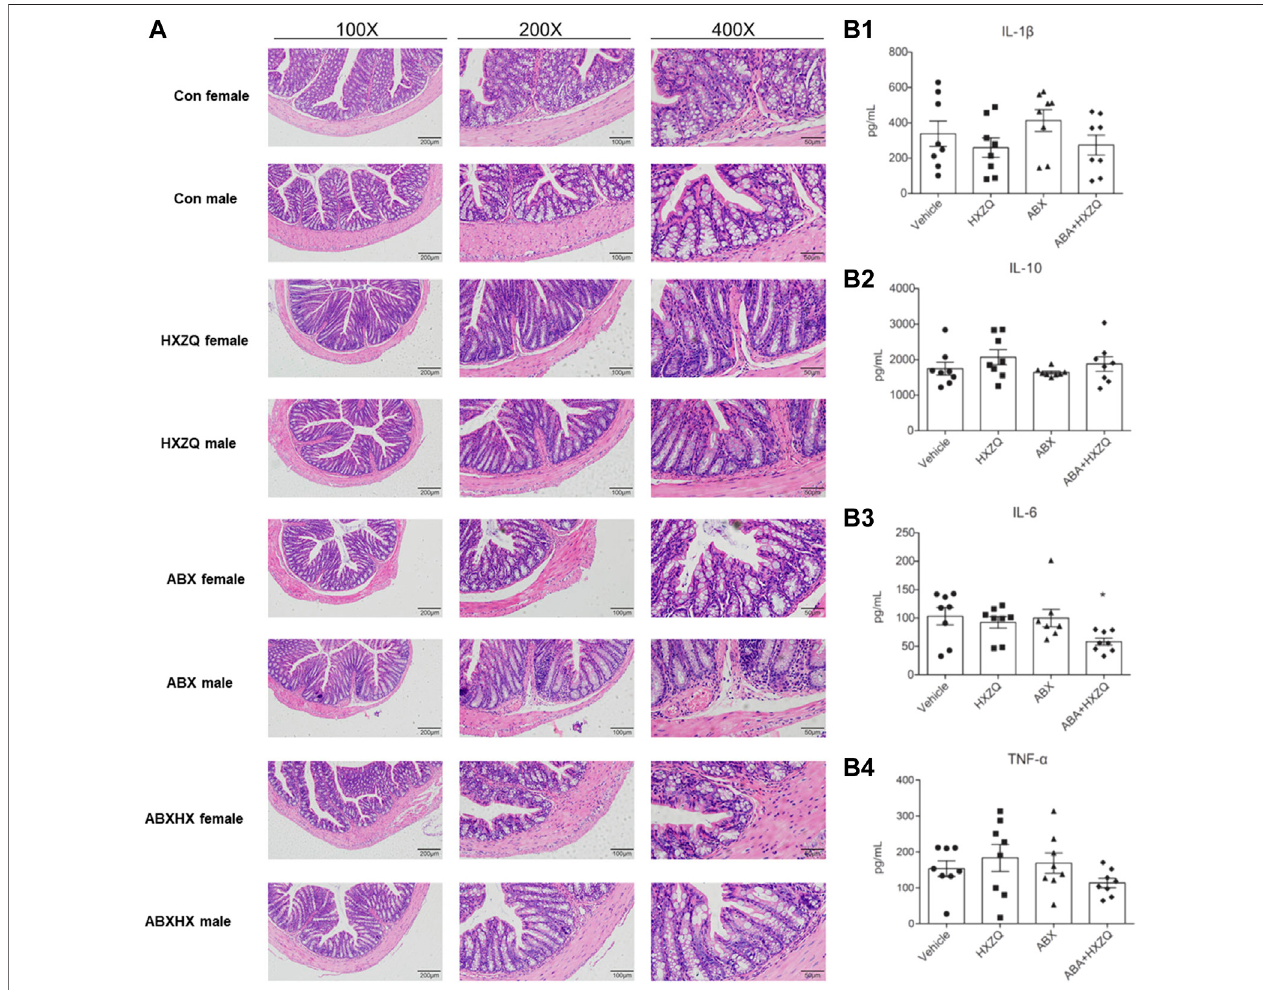
FIGURE 5 | Effects of HXZQ on immuno-microenvironment in colon tissue of mice. (A) Hematoxylin – eosin staining was used to detect morphological changes in structure of colon. (B) Concentrations of four in fl ammatory indicators in plasma were detected using ELISA kit analyses. Data were reported as mean ± SEM. Statistical analysis was performed using an independent Student t -test. * p -value < 0.05, represented signi fi cant